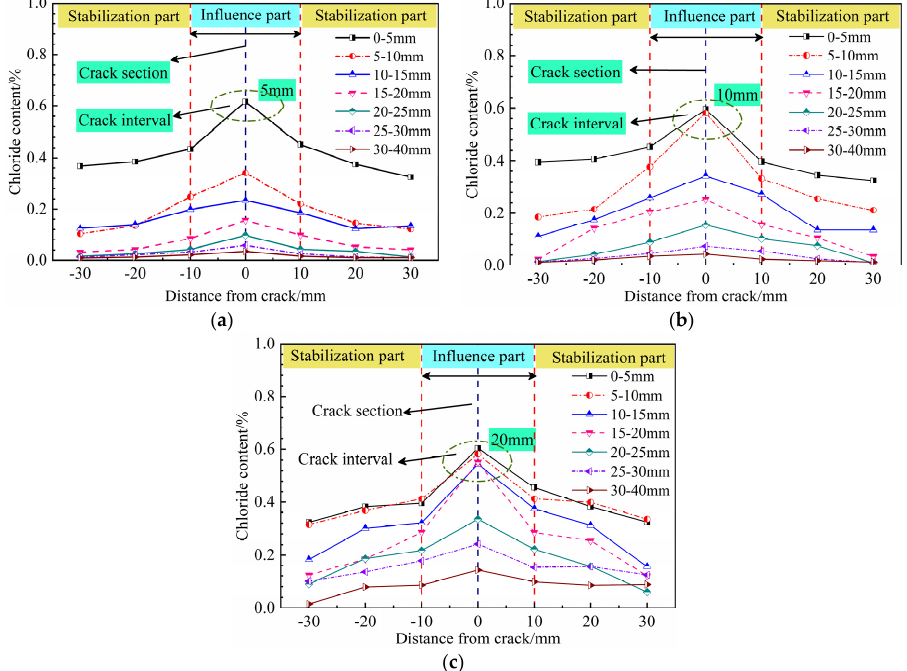
Figure 7. Two-dimensional chloride concentration profiles for specimens with crack depths of ( a ) 5 mm, ( b ) 10 mm and ( c ) 20 mm.